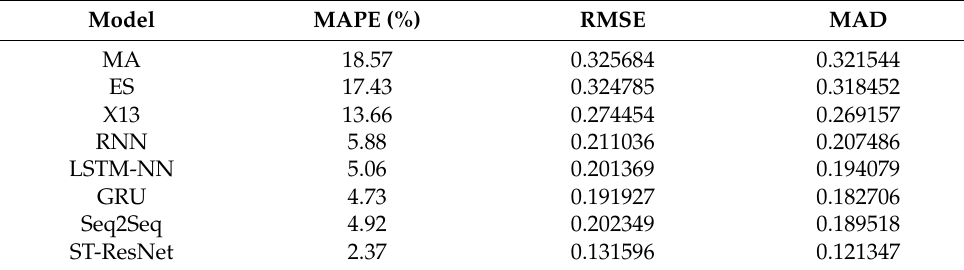
Table 2. Comparison of ultra-short-term forecasting